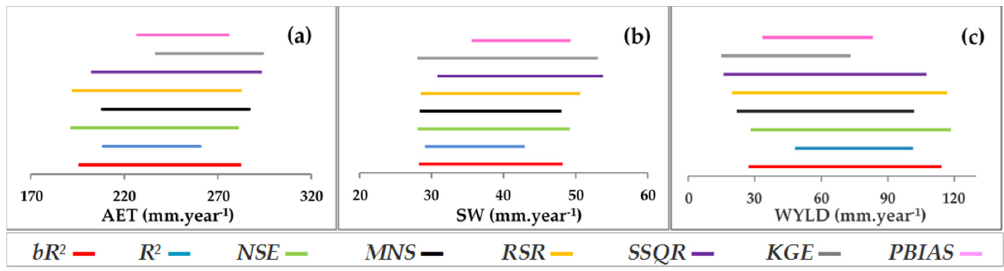
Figure 4. Uncertainty ranges of annual average ( a ) actual evapotranspiration (mm·year − 1 ), ( b ) soil water (mm·year − 1 ), and ( c ) water yield (mm·year − 1 ) derived by different objective functions in Salman Dam Basin (SDB).